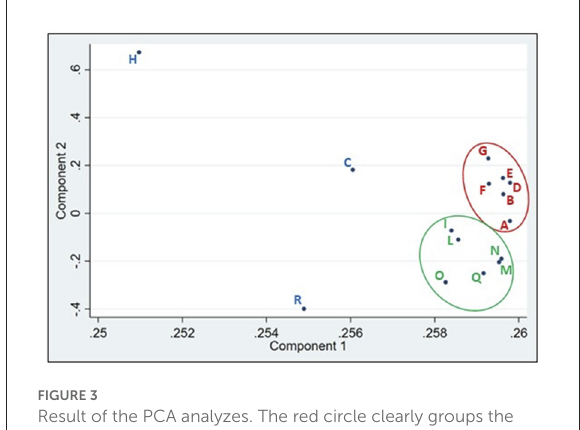
FIGURE3 Result of the PCA analyzes. The red circle clearly groups the sampling points that are before the Milan region and those ones included in the green circle those that are located in the agricultural-zootechnical region.